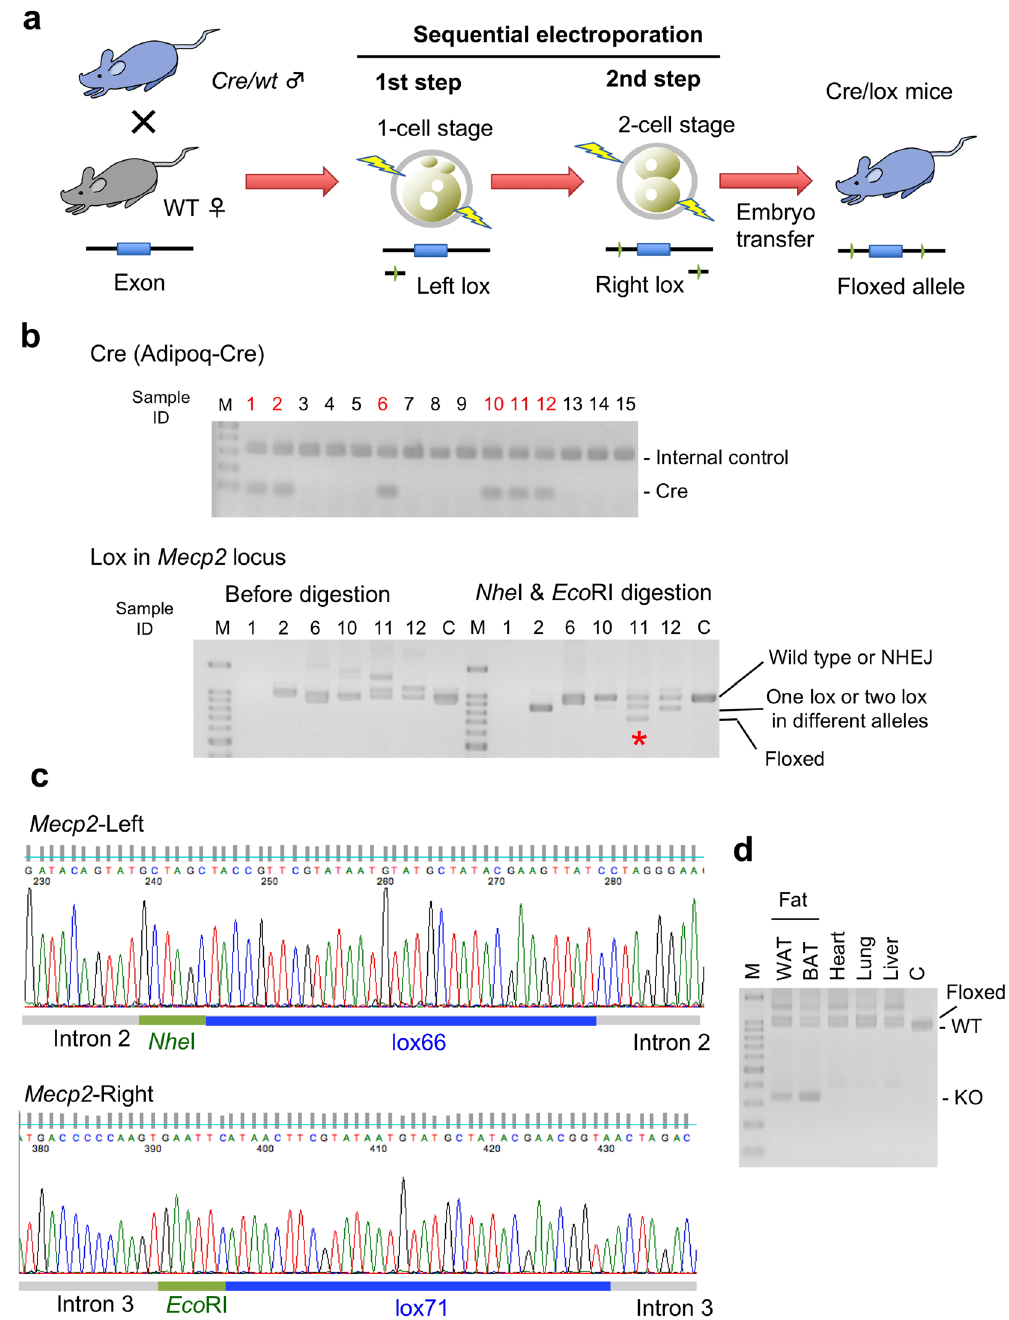
Figure 2. Direct production of Cre/lox mice via sequential electroporation using Cre zygotes. ( a ) Schematic of experimental procedures to generate Cre/lox mice directly. Lox66 and lox71 were inserted into the Mecp2 locus by sequential electroporation using Adipoq-Cre zygotes. ( b ) PCR and RFLP assays show efficient production of Cre/lox founder mice. The samples containing the Cre transgene are indicated in red, and a floxed allele is indicated by a star. Genomic DNA from sample No. 1 was not amplified by lox PCR, suggesting that it contained a chromosomal deletion. In this experiment, one out of five (20%) Cre transgenic mice had a floxed allele. Single digestion and full-length data are presented in Fig. S9. C, wild type mice; M, DNA molecular marker (100 bp ladder). ( c ) DNA sequences of floxed alleles for a female mouse generated by lox66 and lox71 insertion at the Mecp2 locus using Adipoq-Cre zygotes. The data indicate that this Cre transgenic mouse contained the correct floxed sequence. (d) PCR analysis of several tissues derived from the founder Cre/lox mouse ( Adipoq cre/ wt , Mecp2 flox/wt ) showed a fat tissue specific deletion in the Mecp2 gene. WAT, white adipose tissue; BAT, brown adipose